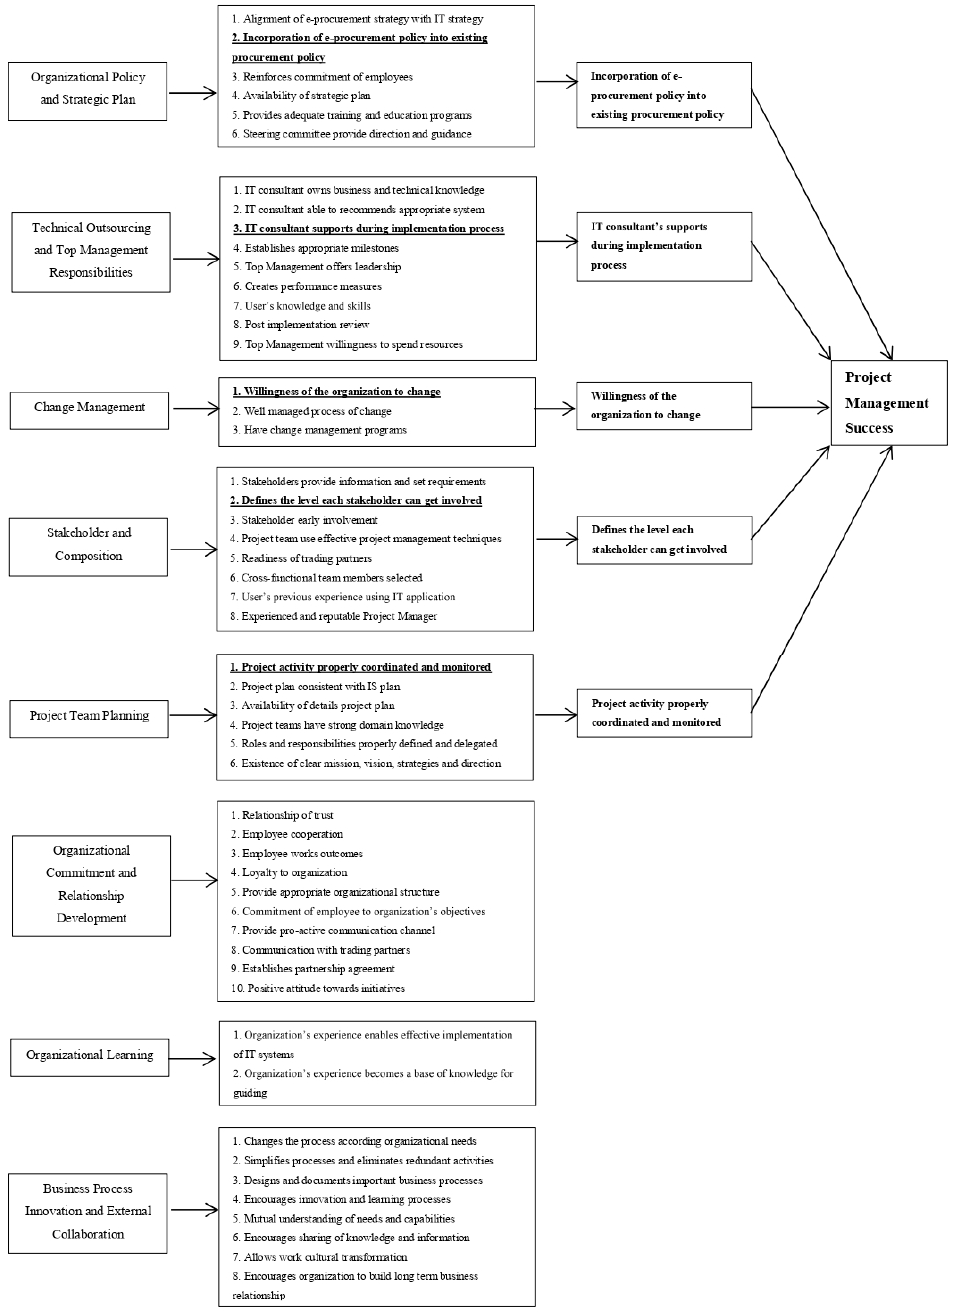
Figure 6. e-procurement Implementation Success (ePIS) framework for project management success.